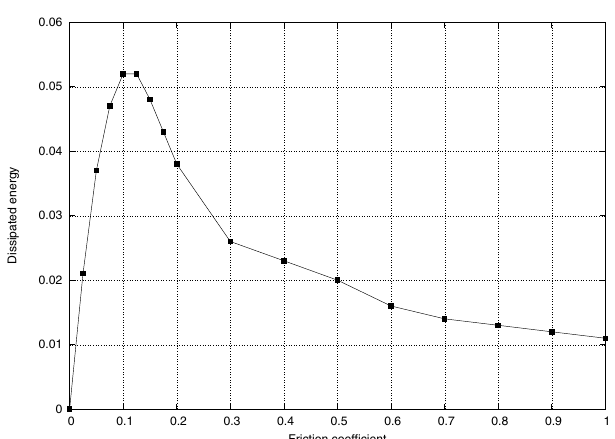
Fig. 4. Energy evolution without friction.